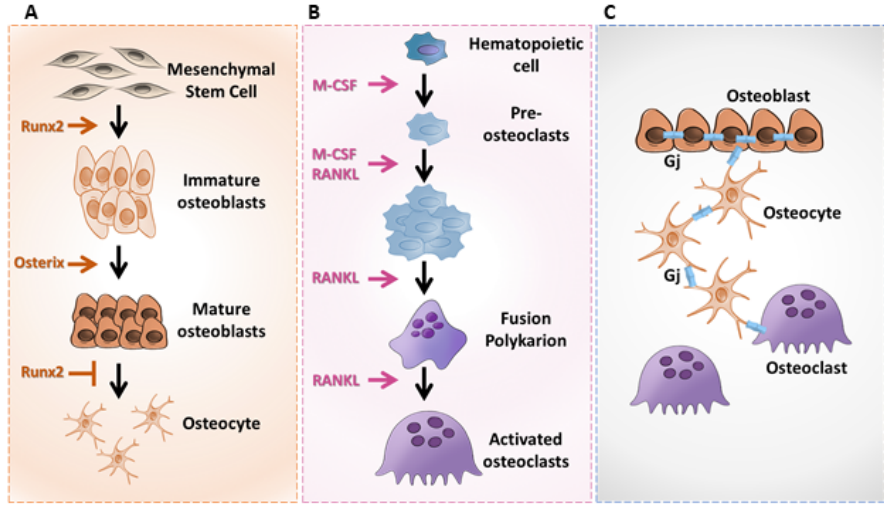
Figure 2. ( A ) Osteoblast differentiation. ( B ) Osteoclast differentiation. ( C ) Schematic representation of the gap junction communication (Gj) between bone cells.